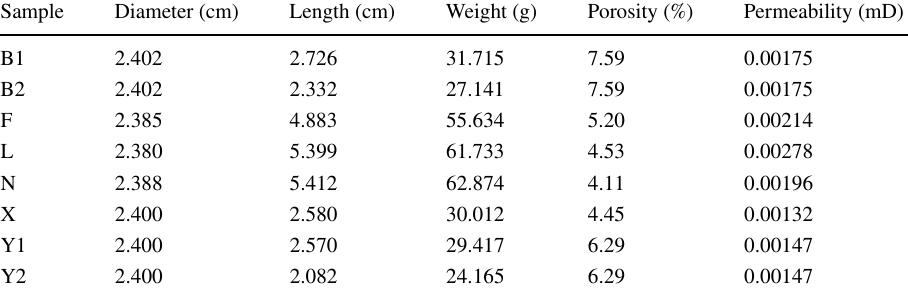
Table 1 Physical properties of shale samples